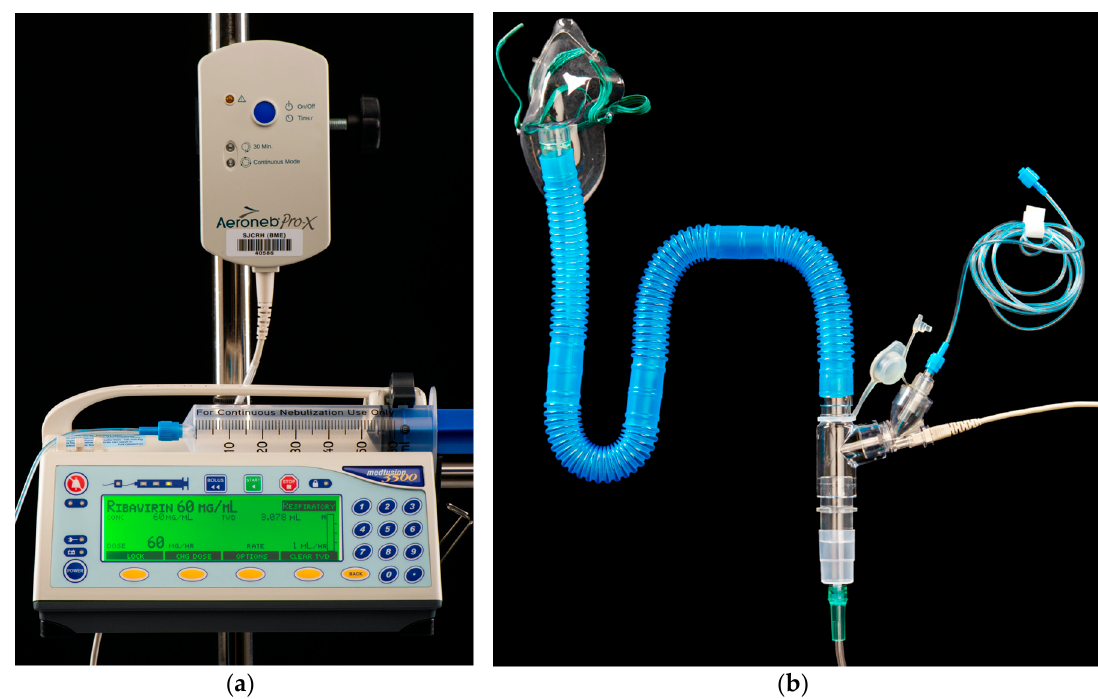
Figure 1. Set up and connection to administer inhaled ribavirin with the Aerogen ® Solo ( a ) MedFusion 3500 syringe pump containing ribavirin at a concentration of 60 mg/mL connected to nebulizer; ( b ) aerosol mask, large bore tubing and T adaptor connection.